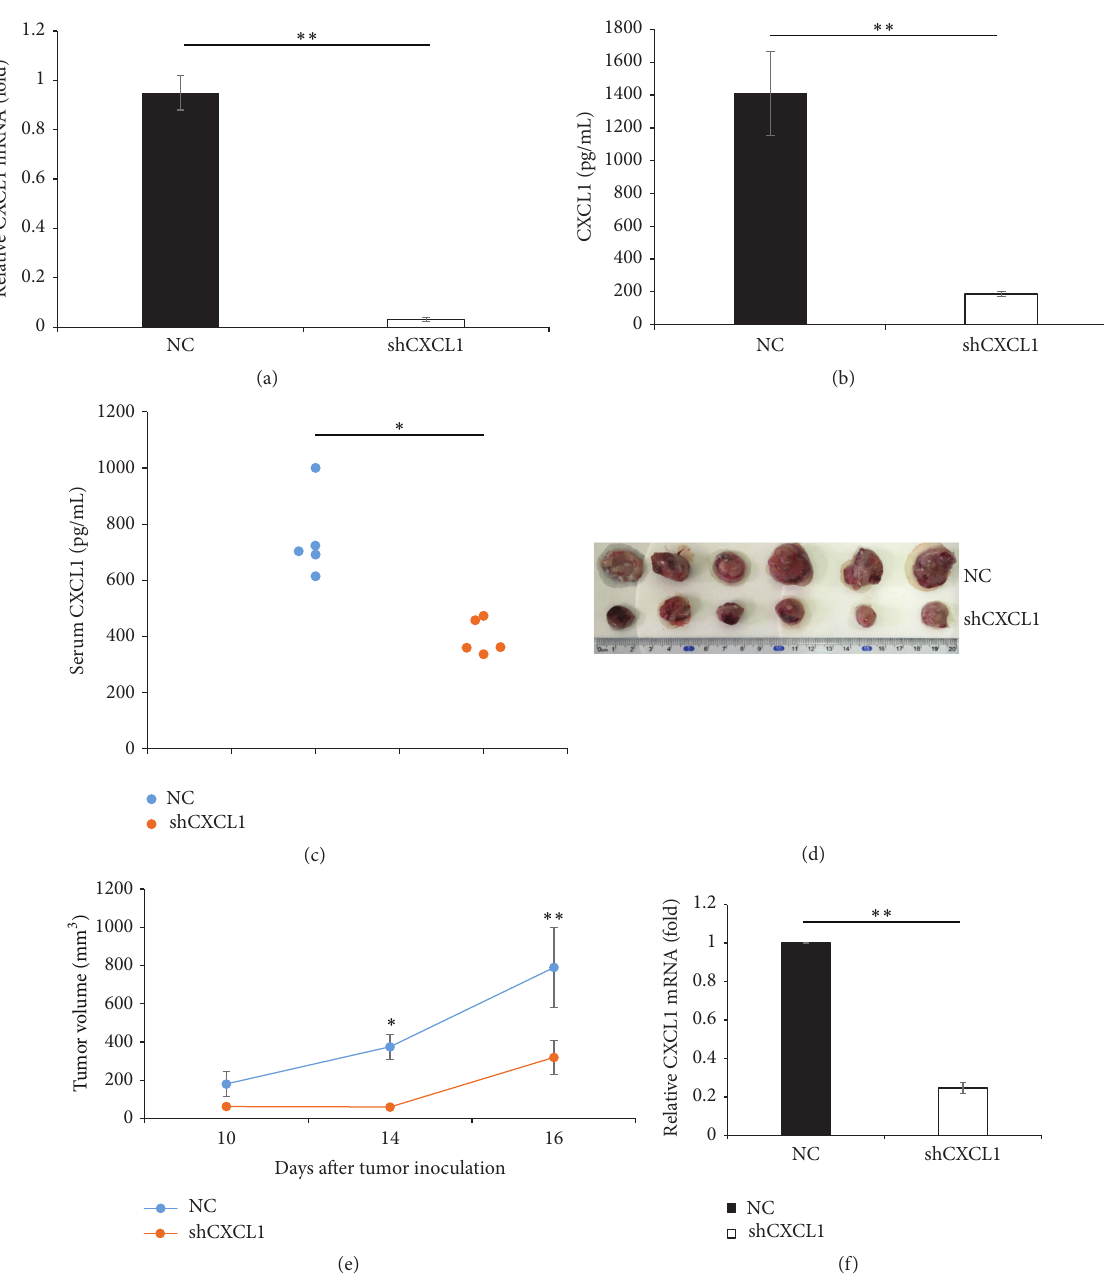
Figure 2: Ablation of CXCL1 in 3LL cells limits tumor growth in vivo . (a) 3LL cells were stable transfected with negative control shRNA (NC) or specific CXCL1 shRNA (shCXCL1); CXCL1 mRNA expression was measured by quantitative RT-PCR. (b) Protein levels of CXCL1 in the 3LL/NC and 3LL/shCXCL1 supernatants were measured by ELISA. (c) Serum levels of CXCL1 from 3LL/NC or 3LL/shCXCL1 bearing mice weremeasuredbyELISA.Eachdotrepresentsanindividualmouse.(d)Primarytumorsexcisedfrom3LL/NCbearingmiceand3LL/shCXCL1 bearing mice at day 16 after tumor inoculation. (e) Growth of NC and shCXCL1 tumors was monitored for 16 days after cell inoculations. (f) CXCL1 mRNA expression in tumor tissues derived from 3LL/NC or 3LL/shCXCL1 tumor-bearing mice was examined by quantitative RT-PCR. ∗ 𝑝 < 0.05 , ∗∗ 𝑝 < 0.01 . Results are shown as mean ±